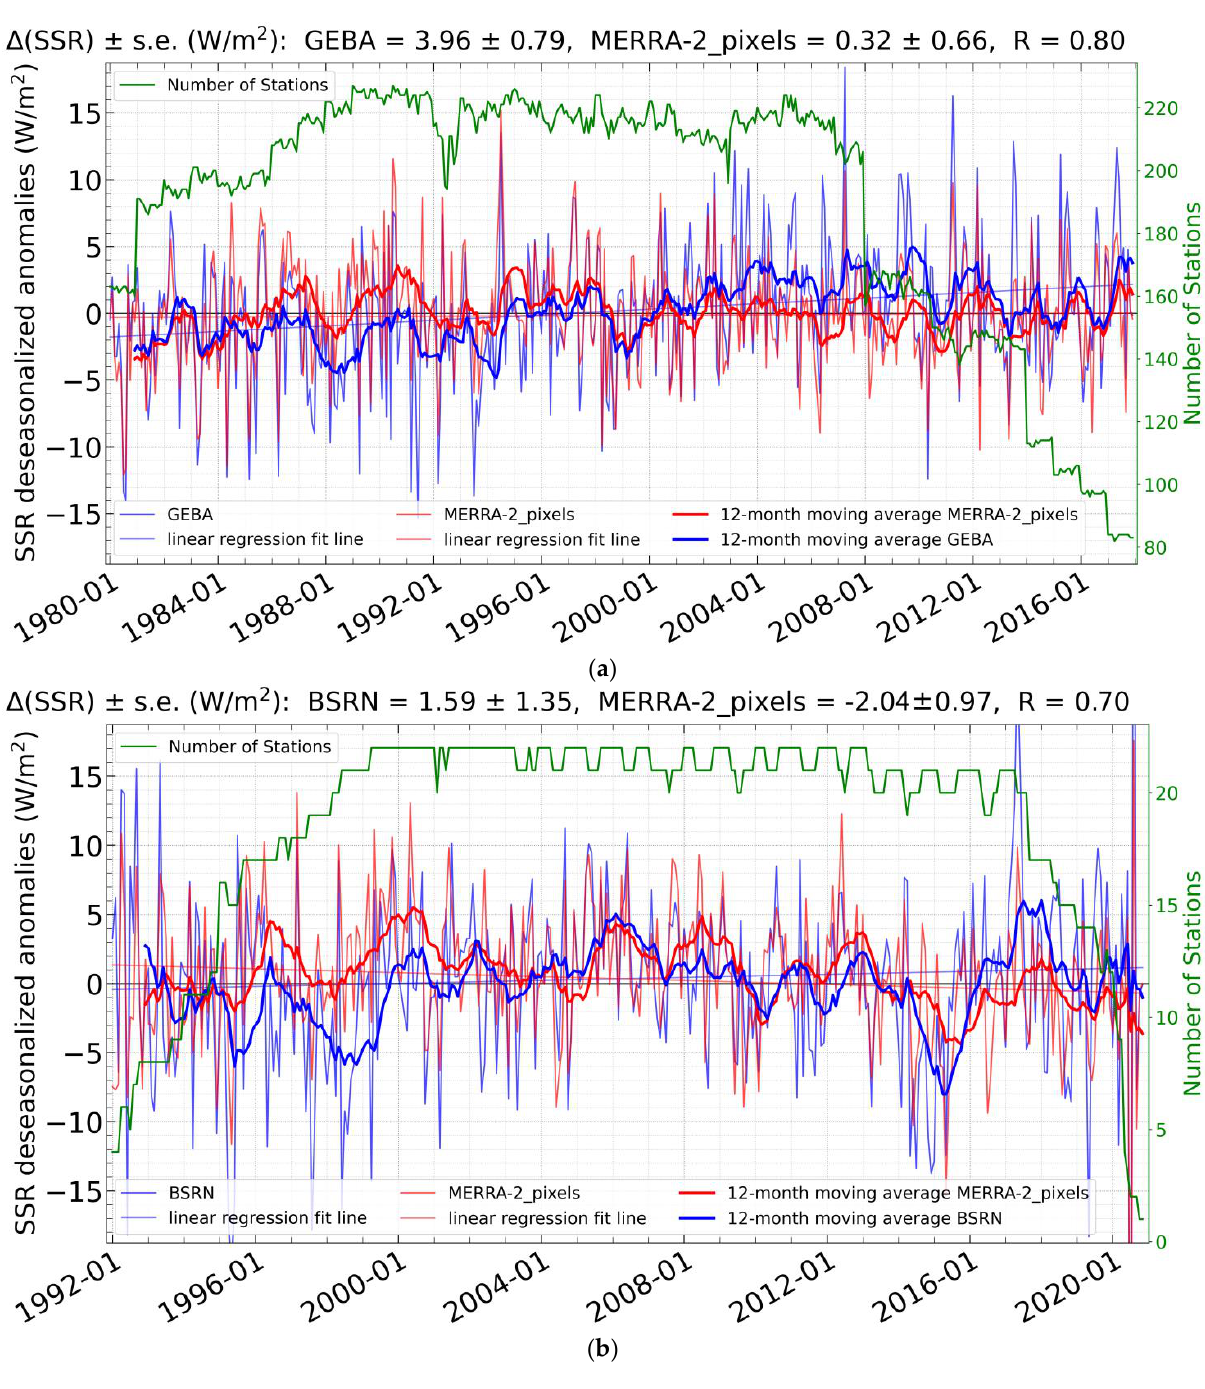
Figure 7. Time series of averaged SSR anomalies for GEBA stations (( a ), blue curve) and BSRN stations (( b ), blue curve) along with those for the corresponding MERRA-2 pixels (red curves). The number of available stations for each month is also shown in green color. 12-month moving averages for each time series are also shown in same colors. The computed ∆ (SSR) and the associated standard deviation along with the correlation coefficient (R) between the two sets of time series (1980 – 2017 for GEBA and 1992 – 2020 for BSRN) are given at the top of figure.